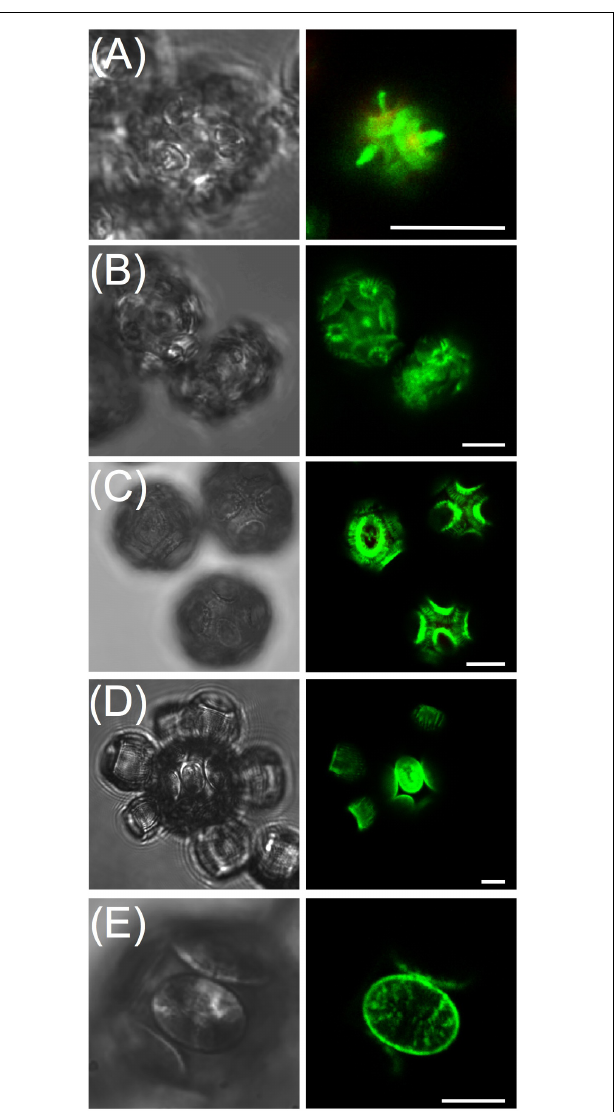
FIGURE 3 | Calcein labeled coccoliths. Confocal sections illustrating the heterogeneous calcein labeling of heterococcoliths. (A) Gephyrocapsa oceanica ; (B) Calcidiscus leptoporus ; (C) Coccolithus braarudii ; (D) Scyphosphaera apsteinii. (E) Detail of a murolith of S. apsteinii . Scale bars represent 5 µ